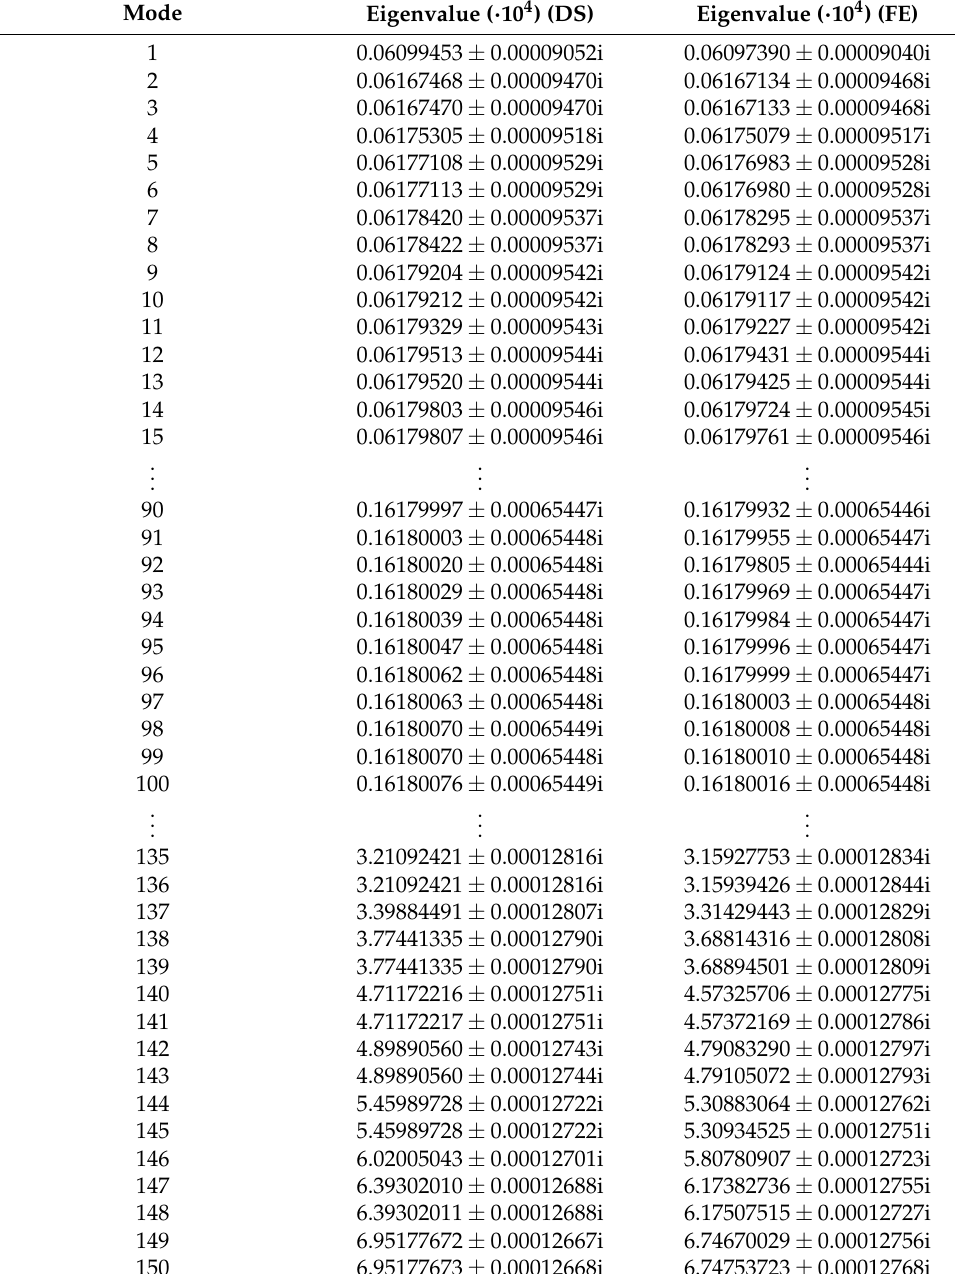
Table 1. Complex eigenvalues (from 1 to 150) of the LRMP in Figure 3 with 2-DOF resonators, computed by means of the proposed dynamic-stiffness approach (DS) and the FE method